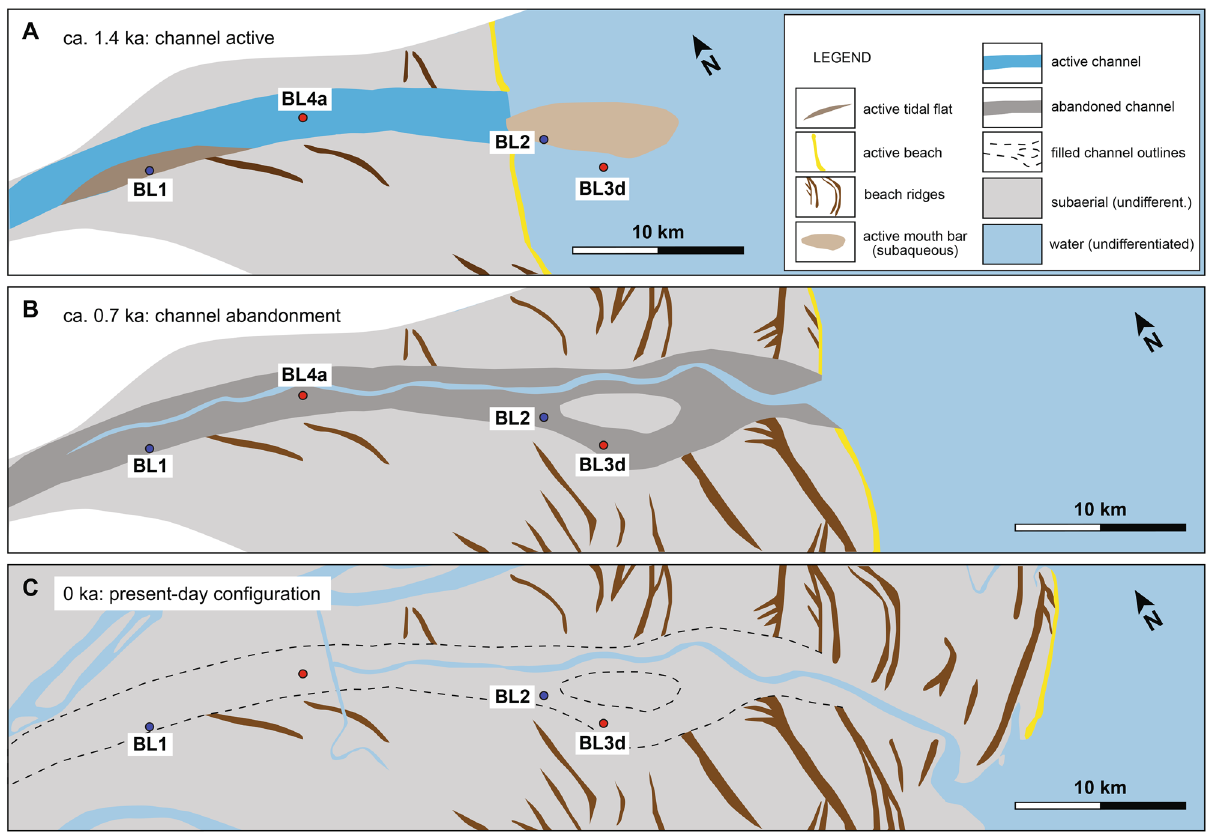
Figure 6. Palaeogeographic reconstructions showing ( A ) the active phase of the Ba Lai channel, ( B ) its abandonment, and ( C ) the present-day configuration. White parts indicate areas of uncertainty regarding the evolution of the neighbouring channels. Beach ridges were identified using the DEM and 21 . The palaeogeographies also show the progradation of the shoreline changing from symmetrical to asymmetrical when the channel was other cores, with the active-channel fill having sedimentation rates of 0.1–0.5 cm/yr in the cores BL1 and BL4a, and the abandoned-channel fill even reaching 11.1 cm/yr in the BL3d core. Therefore, during its active phase the channel mainly aggraded at a few millimetres per year, which is consistent, for example, with active channels in anastomosed fluvial systems 4 . By contrast, during the abandoned phase the channel aggraded much faster, in the order of centimetres to decimetres per year. The consistent ages at 0.7 ka for the abandoned-channel fill suggest that the channel was filled rapidly in the order of decades or maximum a few centuries. Using the 2-sigma distribution of AMS 14 C ages from the abandoned-channel fill and excluding one reversed age (Supplementary Information 2), the difference between the absolute minimum and maximum ages is 232 years; this value might suggest an approximate time range in which the abandoned channel was infilled. Also, given an average thickness of 5 m and sediment accumulation rates between 1.9 cm/yr and 11.1 cm/yr for the abandoned-channel fill, it is calculated that the channel could have been infilled in as little as 45–263 years after its abandonment. Furthermore, an additional consideration can be made based on the MRD sediment supply. At quasi-natural conditions (i.e., before dams, sand mining, etc.), the sediment discharge of the MRD was estimated in 160 Mt/yr 26 , of which approximately 27% flows through the My Tho channel located north-eastward of the Ba Lai 14 . If assuming that the delta configuration and discharge were similar at 0.7 ka, it could be expected that the sediment exported by the My Tho channel would be transported predominantly south-westward due to the dominant current in the area; part of this sediment would have been reimported to fill the Ba Lai channel (Fig. 8). If assuming that one fifth of the sediment annually exported by the My Tho would have been used to infill the abandoned channel, the complete fill of the latter could have occurred in 69 yr. If assuming one tenth of the sediment, the fill could have been completed in 139 yr. These values seem realistic considered the dynamics of the MRD and are included within the time range calculated based on the ages and on the thickness and sediment accumulation rates of the abandoned-channel fill, suggesting that this time-range estimation could be considered reliable.